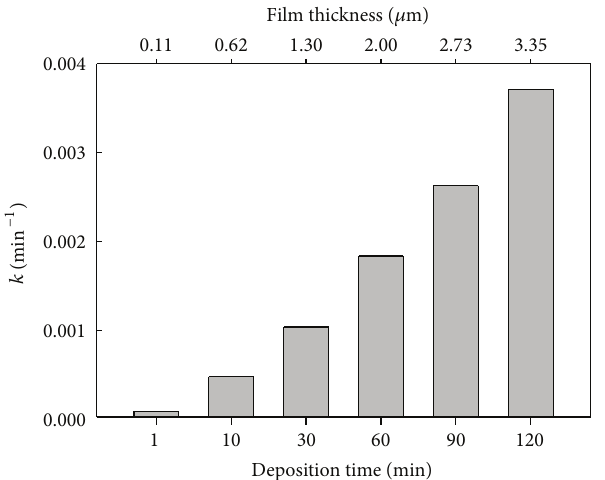
Figure 8: Effect of hierarchically structured TiO 2 film thickness on the apparent first-order rate constant.